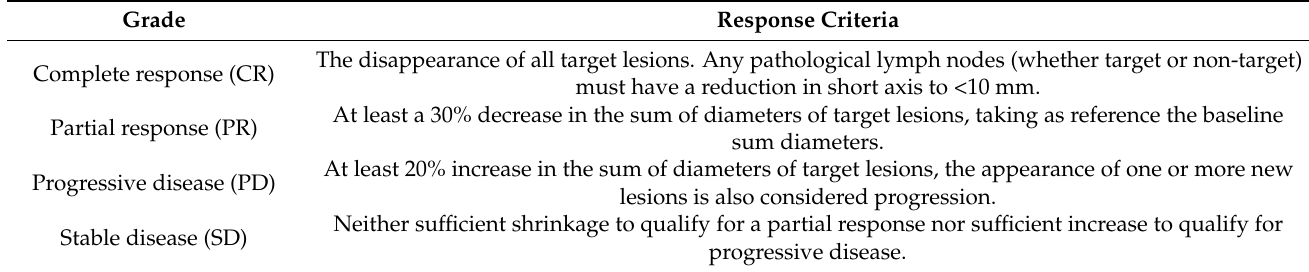
Table 1. Revised RECIST guideline (version